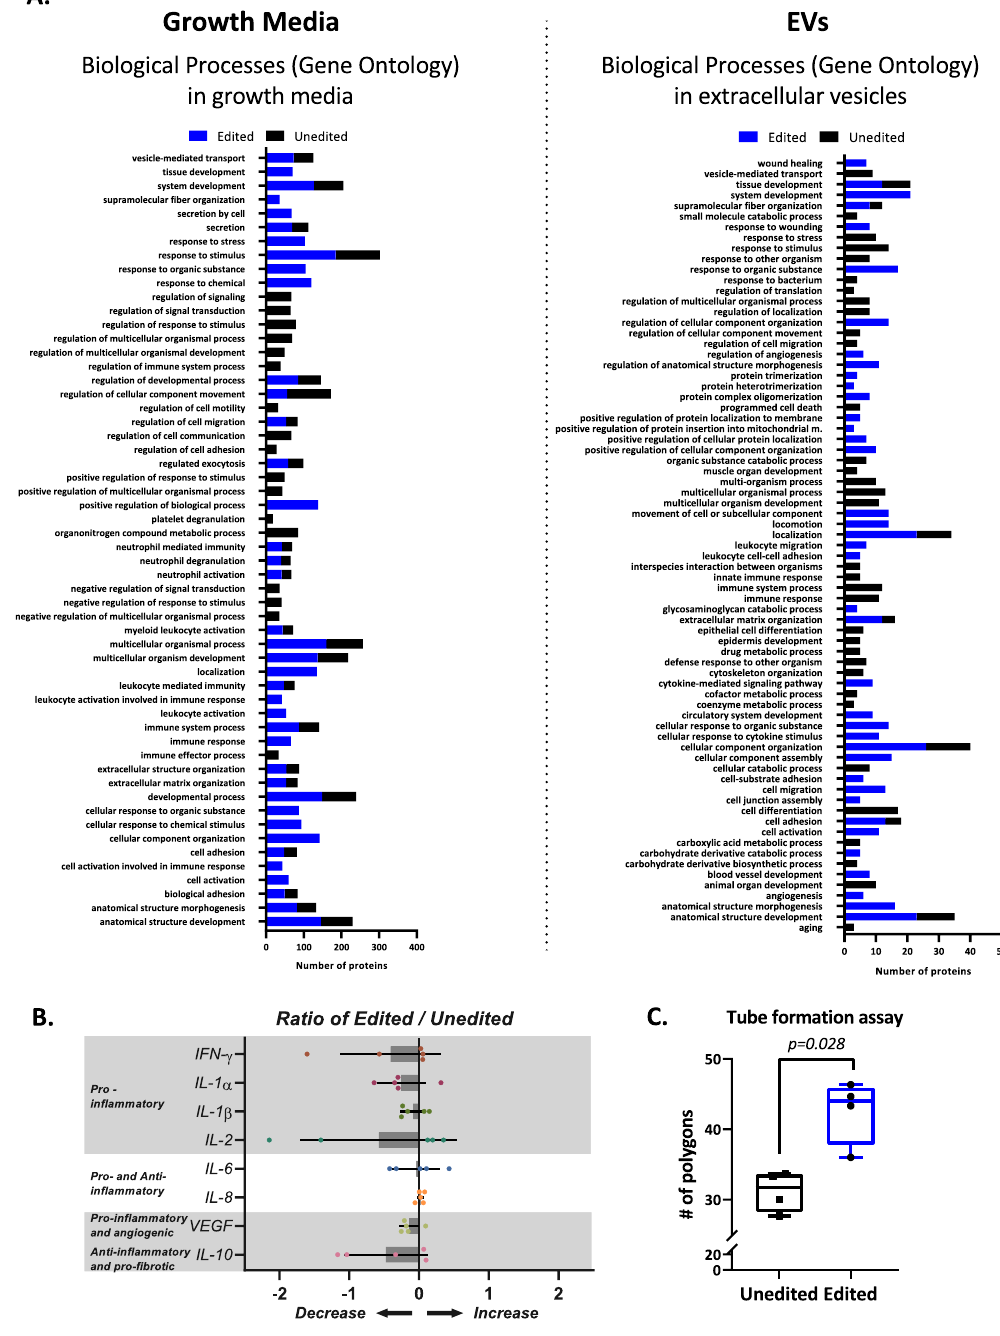
Figure 4. Change in Biological Pathways after Gene Editing in hMSCs. To interpret the changes in the proteomic data before and after gene editing, we clustered the proteins from growth media or EVs by the STRING classification system (https:// string- db. org). For each protein group, datasets of protein lists were composed based on the significance of the change. Proteins that had a significant decrease ( p < 0.05) were grouped into the list of edited cells group, while proteins with no significant change comprised the second list, representing the unedited cells group. ( A ) STRING classification of the 20 most significant biological processes from edited and unedited protein data sets. False-discovery rate according to p values corrected for multiple testing by Benjamini–Hochberg. ( B ) Multiplex ELISA analysis of inflammatory cytokine levels in hMSC growth media of edited vs. unedited cells. Results show lower secretion of pro-inflammatory cytokines from edited hMSCs. Media was collected from 2 × 10 4 cells after incubation for three consecutive days. The ratio was calculated for each patient’s edited/unedited cells to find changes in cytokine secretion (n = 5). ( C ) To determine the angiogenic properties of the edited cell conditioned medium, we used HDMEC Matrigel Tube Formation Assay. The results were quantified after 3.5 h. Abbreviations EVs , extracellular vesicles; hMSCs , human mesenchymal stromal cells; ELISA , enzyme-linked immunosorbent assay; HDMEC , human dermal microvascular endothelial